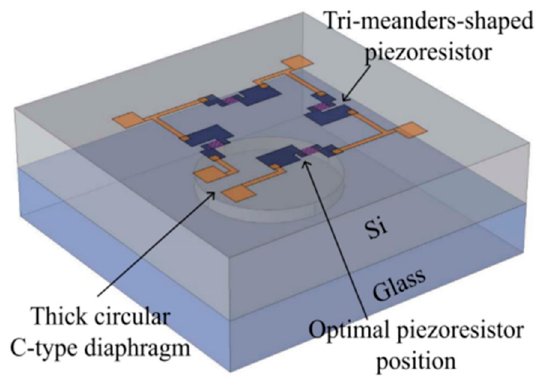
Figure 9. Structure of piezoresistive pressure sensor. Table 2. Testing result of piezoresistive sensor under different pressure.